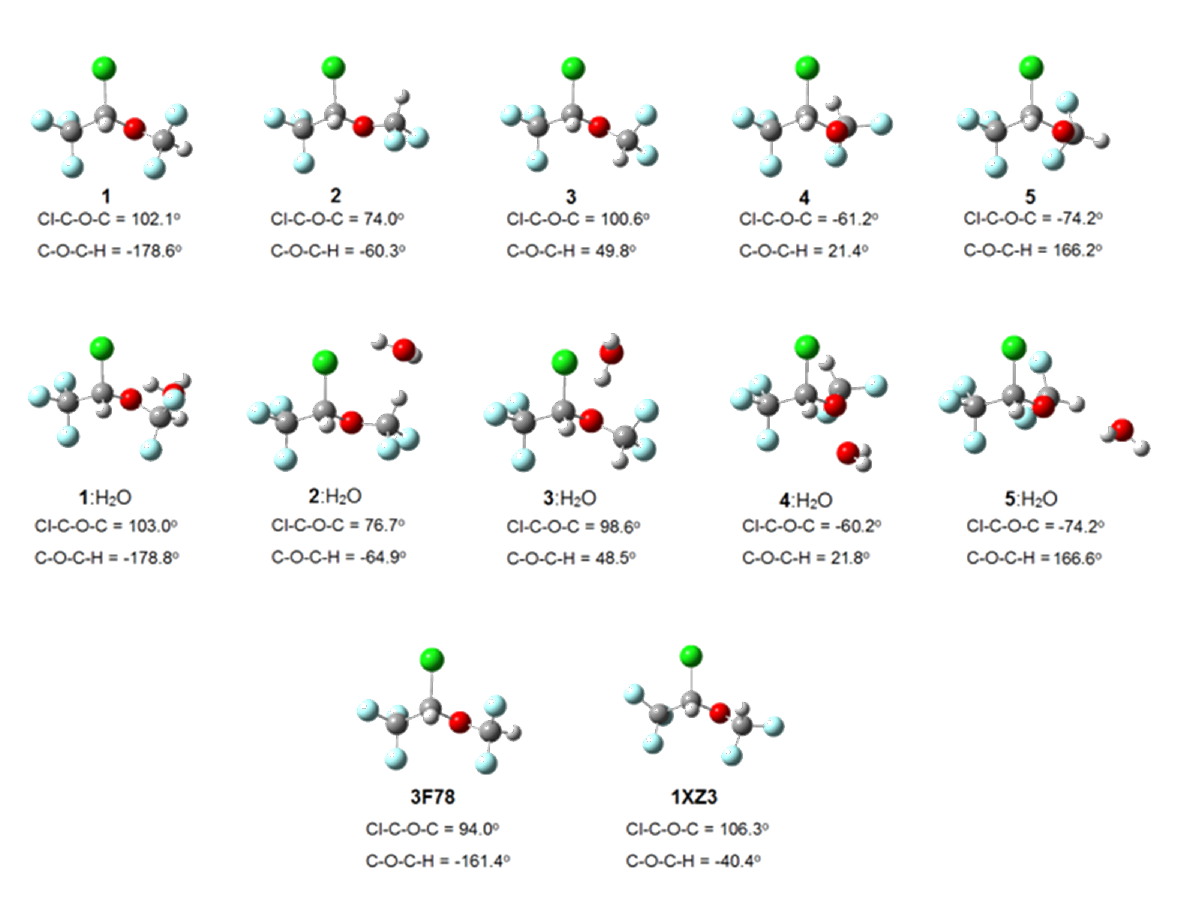
Figure 1: Optimized structures of isoflurane at the ω B97X-D/6-311++g(d,p) level (gas phase and explicit water) and the experimental bioconforma- tions 3F78 and 1XZ3.